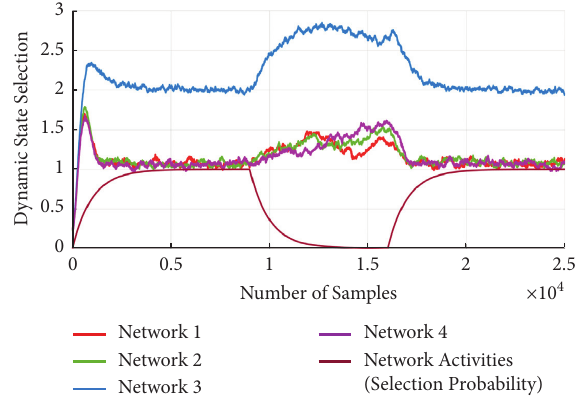
Figure 19: Effect of threshold on network connectivity for threshold � 2 ( S l � 6).